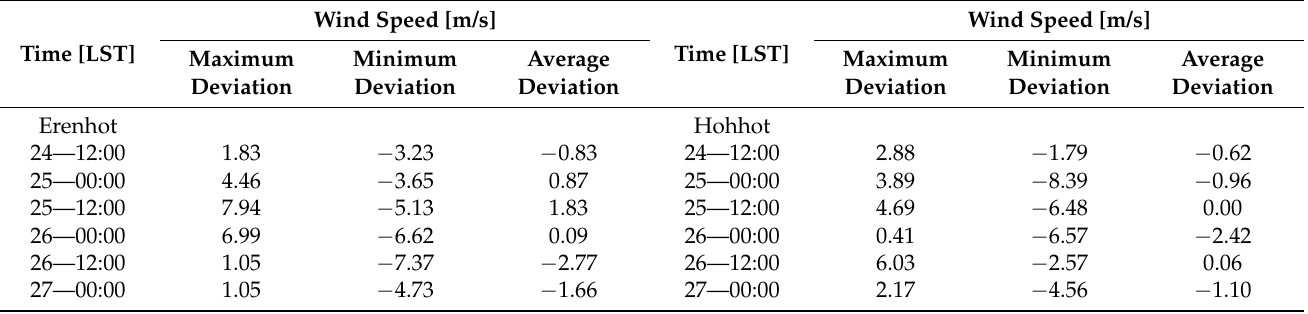
Table 6. Statistical biases of mean wind speed above the main landing area in the “Shen Zhou 10” case.